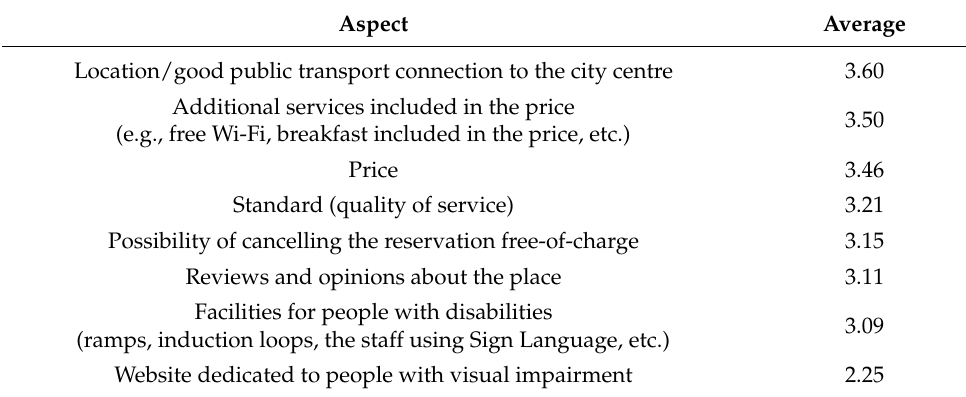
Table 10. Aspects influencing the choice of accommodation.